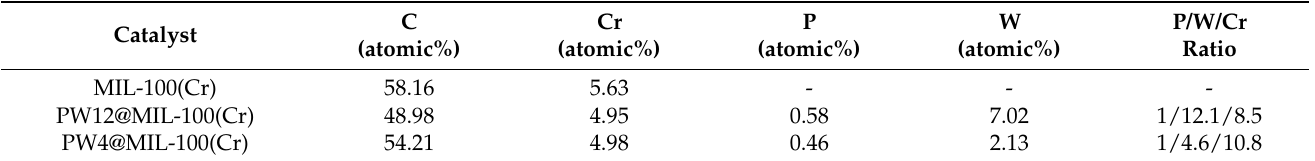
Figure 2. FTIR spectra of MIL-100(Cr) ( a ), PW12@MIL-100(Cr) ( b ), PW4@MIL-100(Cr) ( c ) and PTA ( d ). The FTIR spectrum of PW12@MIL-100(Cr) (Figure 2b) had bands specific to PTA: 1080 (vibrational frequency of P-Oa), 979 (stretching of W=Od), 899 (vibrational fre- quency of W-Ob-W) and 822 cm − 1 (W-Oc-W vibration), where a, b, c and d designated the specific positions of the oxygen atoms in the Keggin structure, namely P–Oa–W 3 , Od=W, W–Ob–W and W–Oc–W, connecting two W 3 O 13 units through corner sharing and edge sharing, respectively [56]. The characteristic peaks of pure phosphoric tungsten acid (889